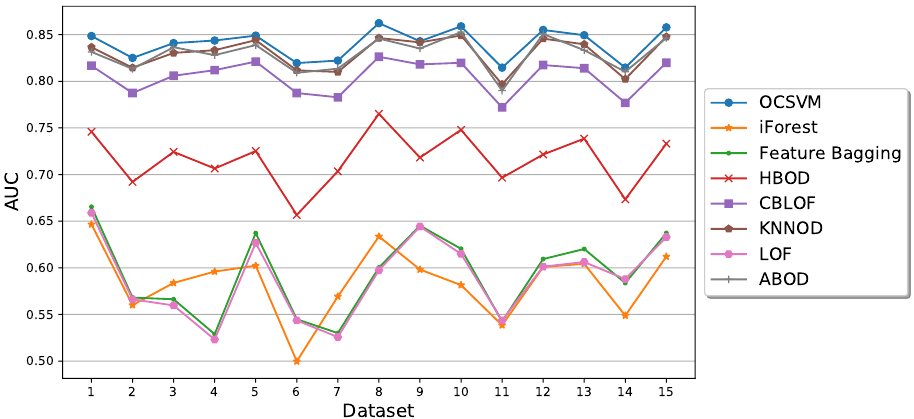
Figure 11. Performance of semi-supervised anomaly detection algorithms using all features in terms of average